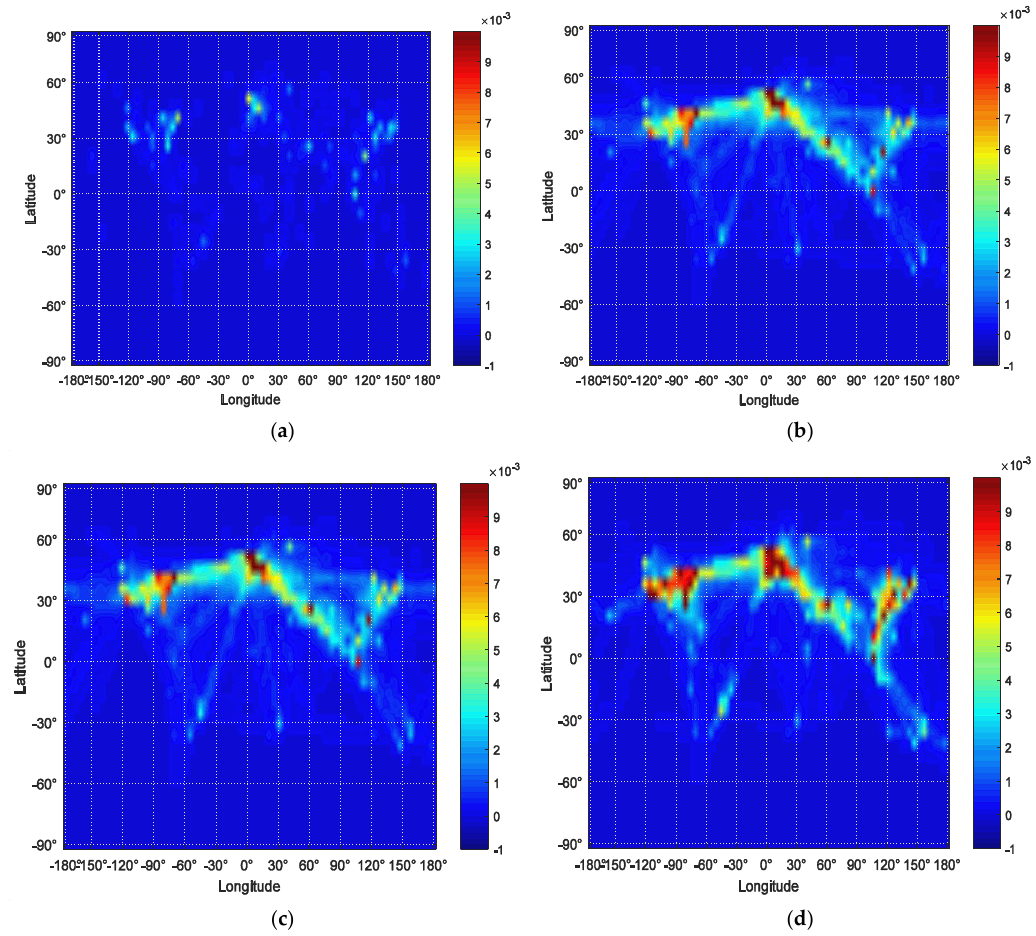
Figure 3. The average (2005–2011) distribution of the global aircraft NO x emissions (in Tg), ( a ) between 5.6 and 7.2 km, ( b ) between 7.2 and 9.2 km, ( c ) between 9.2 and 11.8 km, ( d ) between 11.8 and 16.2 km.